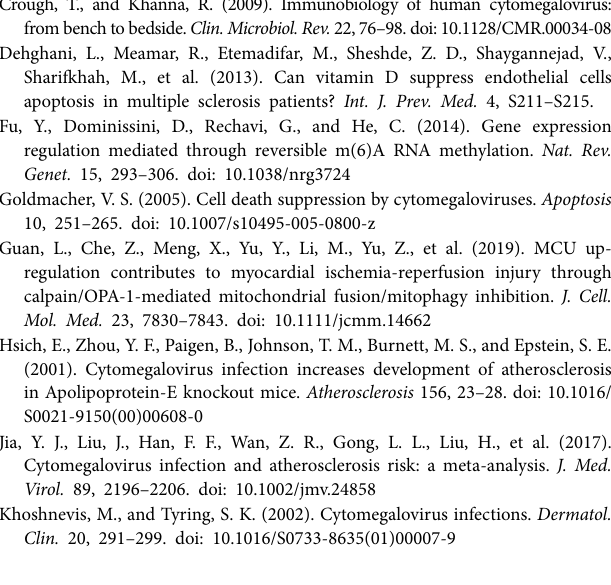
Supplementary Figure 1 | (A–C) Western blot analysis for knockdown efficiency of YTHDF1 (A) , YTHDF2 (B) , and MCU (C) in HAECs with siRNA. (D) Effect of MCU activity on caspase-3 and caspase-9 activities using Caspase-3/9 fluorescent assay kits. (E) Knockdown of METTL14 in HAECs does not affect MCU protein expression. (F) Overexpression of METTL14 in HAECs does not affect MCU protein expression. (G) Sequence display of MCU 3 ′ -UTR with mutated m6A sites. All data are expressed as the mean ± SD of triplicate experiments. Values of p were calculated with student’s t -test, ** p < 0.01 and *** p < 0.001. ns: no significant